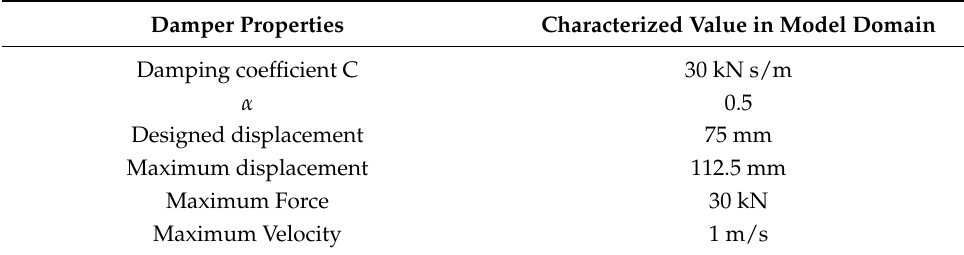
Table 3. Mechanical properties of the